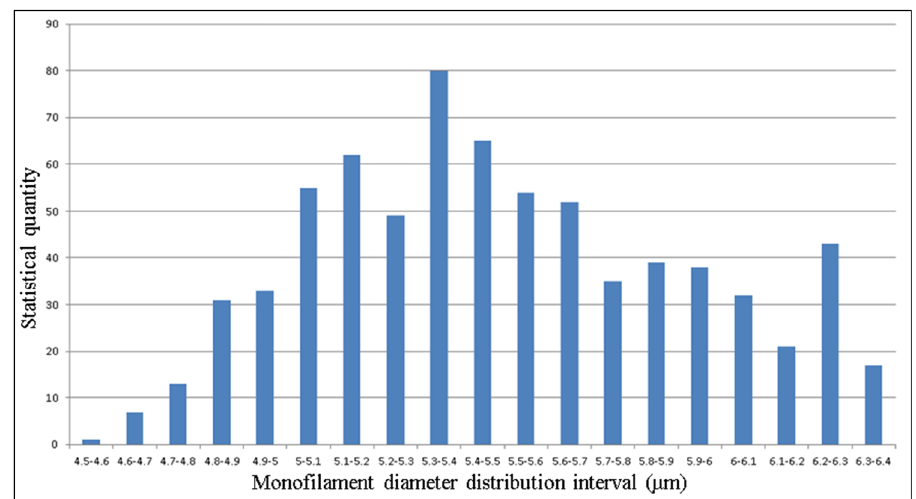
Figure 7: Mono fi lament diameter distribution for D900 glass